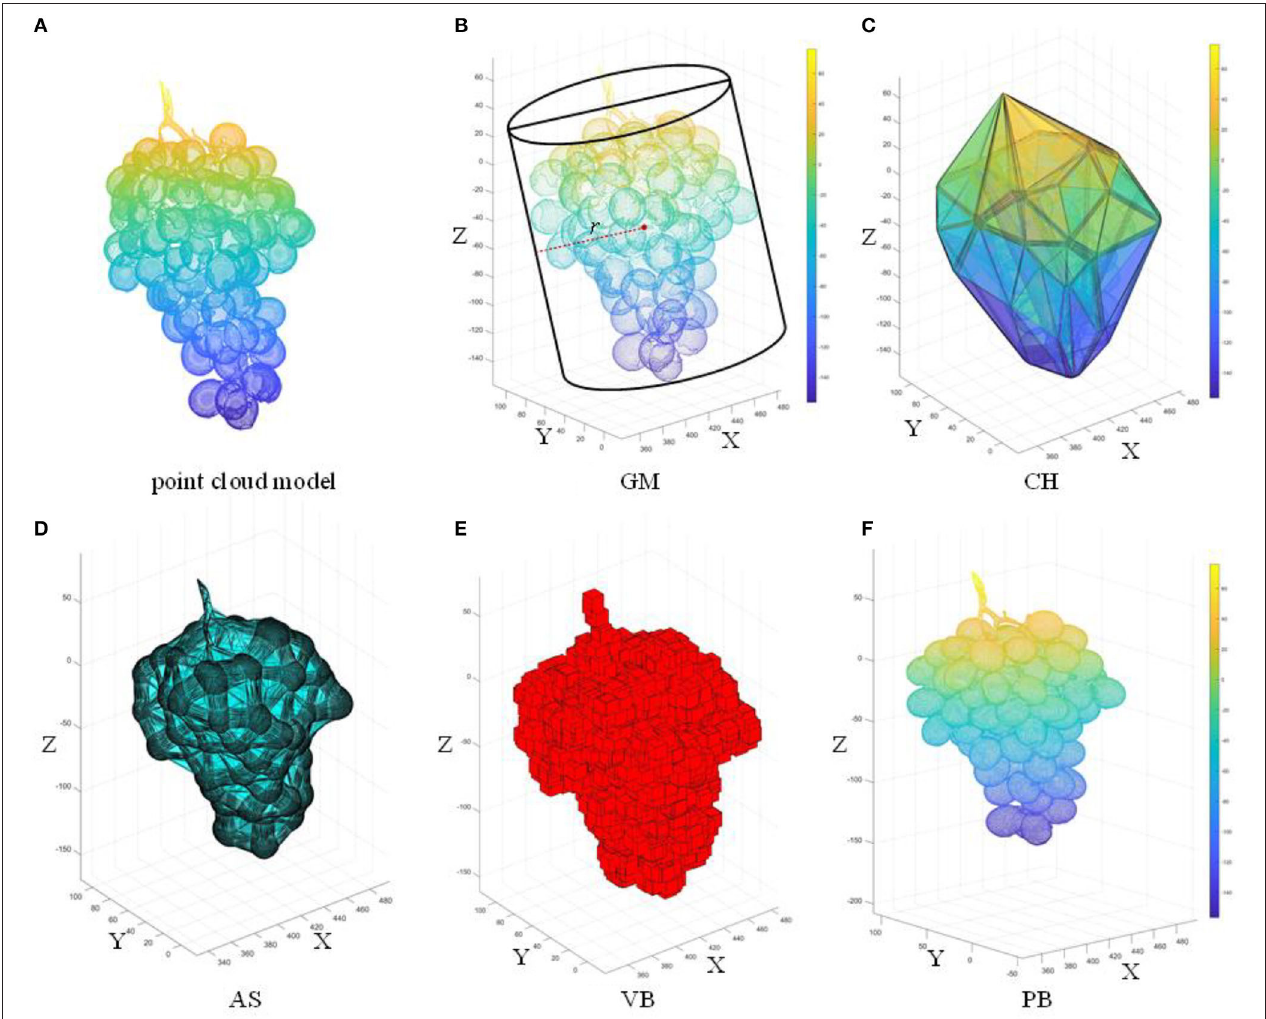
FIGURE 9 | Five surface reconstruction algorithms based on the complete grape point cloud model; (A) original point cloud; (B) GM; (C) CH; (D) AS; (E) VB; (F) PB. l , w , and h are the three dimensions of the grape (length, width, and height, respectively).